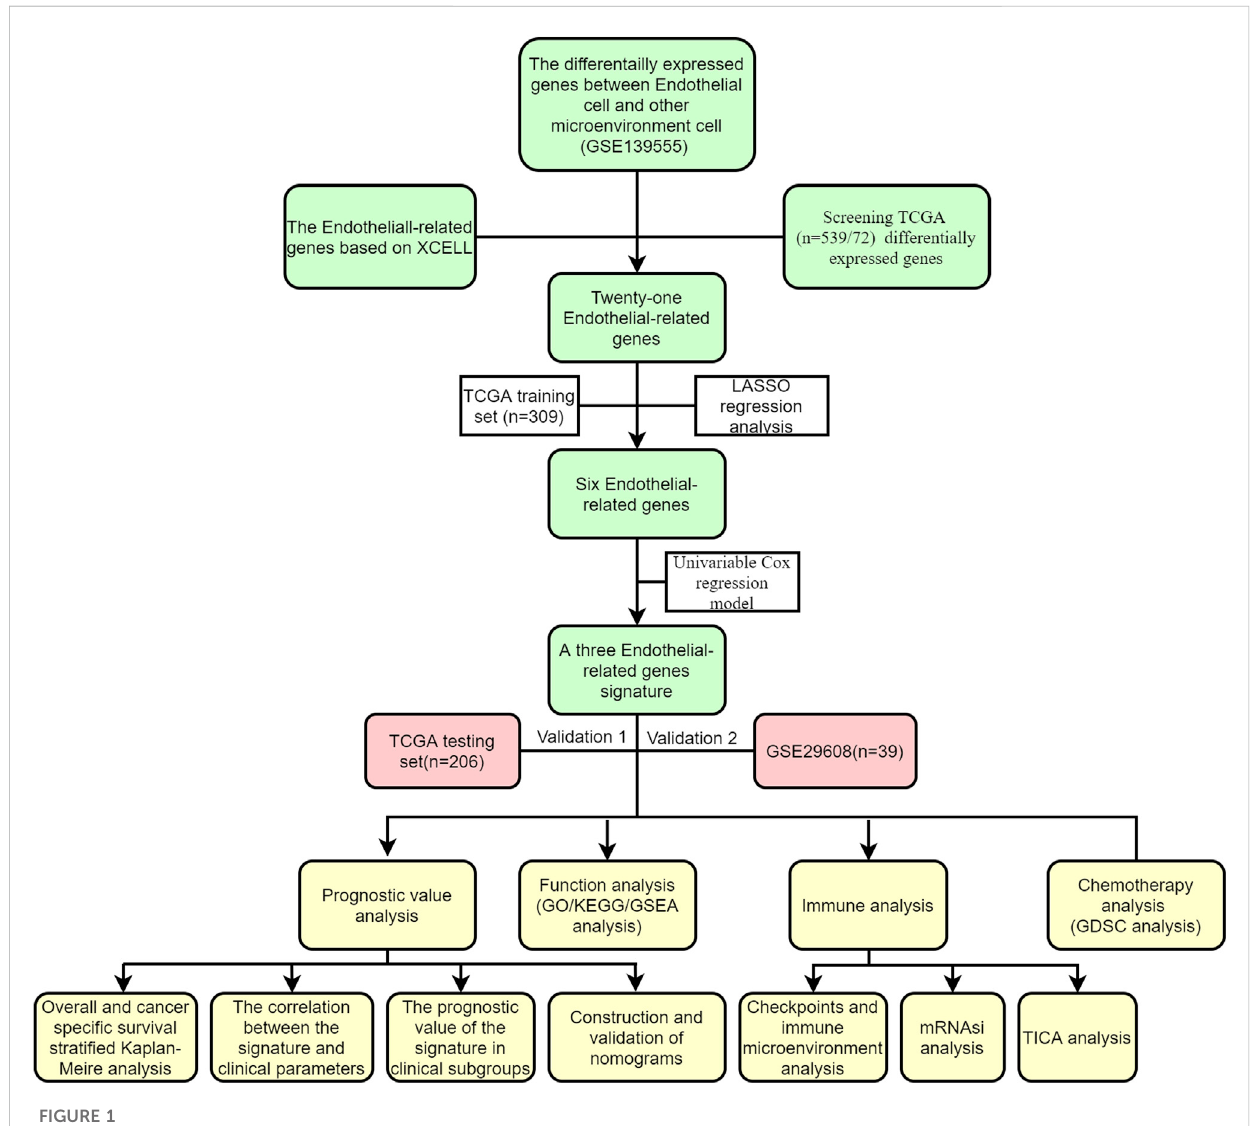
FIGURE 1 The work fl ow of this